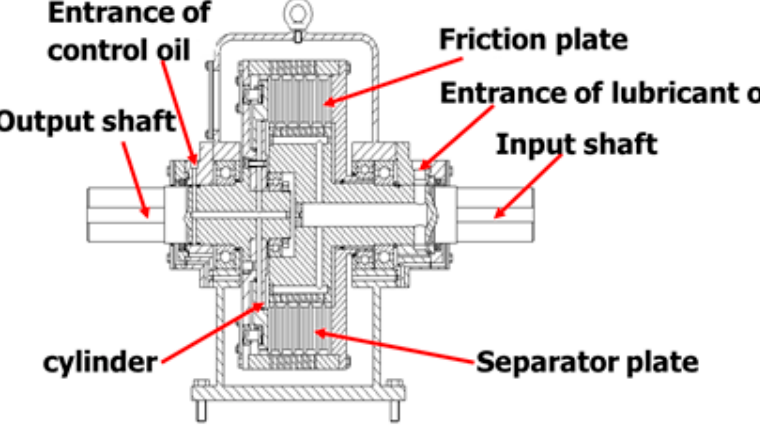
Figure 1. Schematic diagram of hydro-viscous